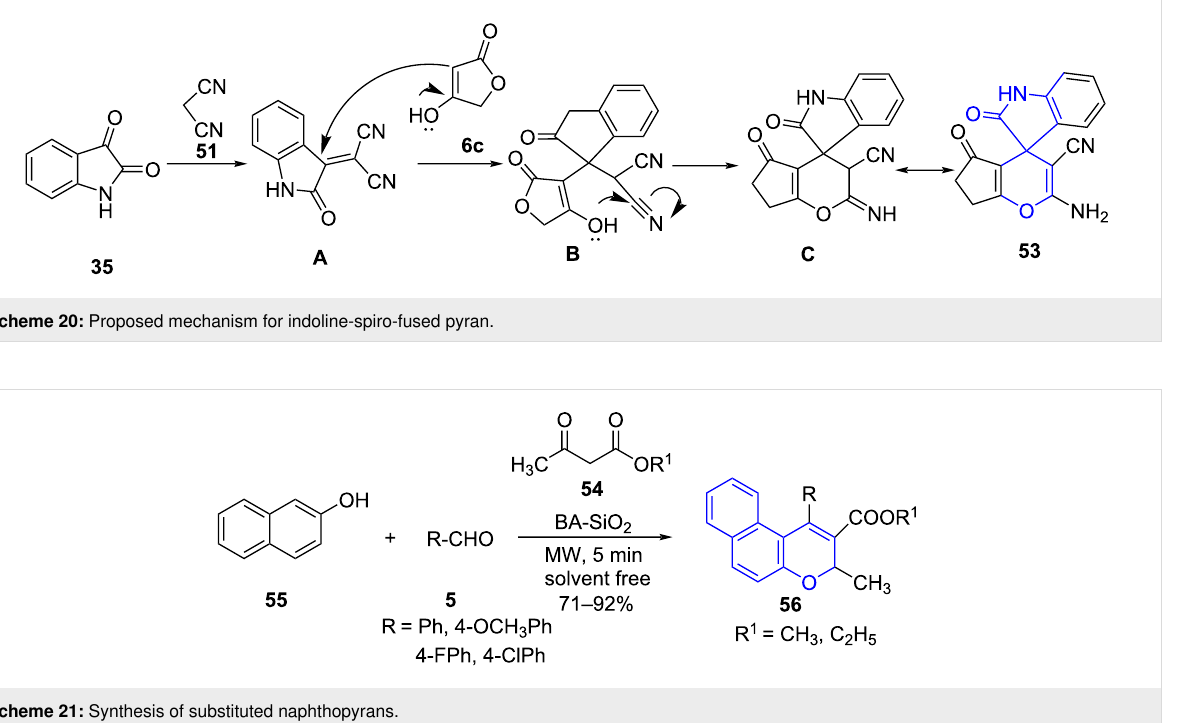
abundant in a plethora of lead molecules and marketed drugs like atorvastatin ( 57 ), elopiprazole ( 58 ), isamoltane ( 59 ) and tolmetin ( 60 , Figure 5)